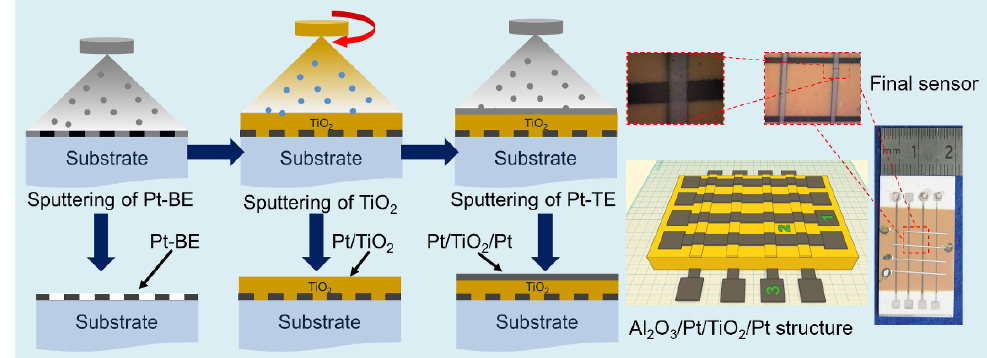
Figure 1. The schematics showing the steps to fabricate Pt/TiO 2 /Pt-based sensors. The figure also includes the real photograph of one of the real sensors (photos at the right hand-side) fabricated in our lab with the procedure mentioned in the experimental part and optical images of the Pt/TiO 2 /Pt based cross-bars in the insets.